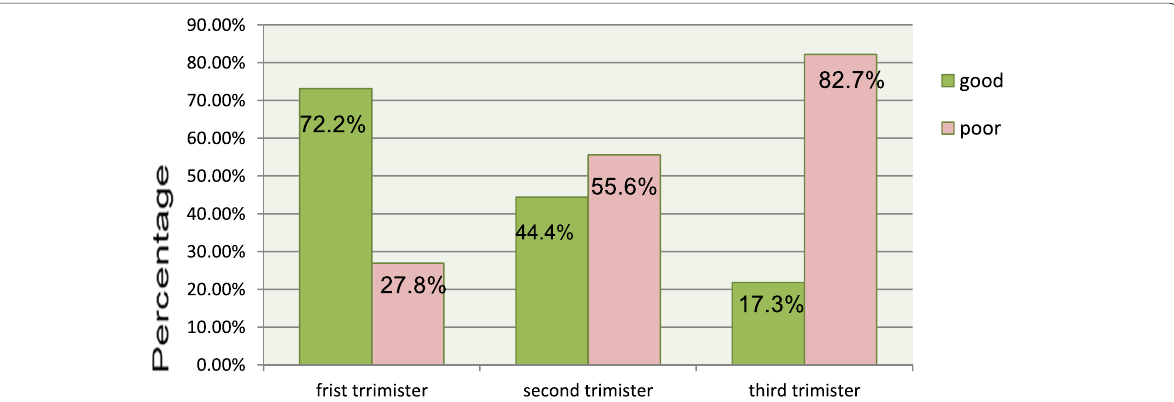
Fig. 1 Figure showing the percentage of poor and good sleep quality across the three trimesters among pregnant women on ANC follow-up at Nekemte Referral Hospital and Wollega University Hospital, Nekemte, Ethiopia, 2019